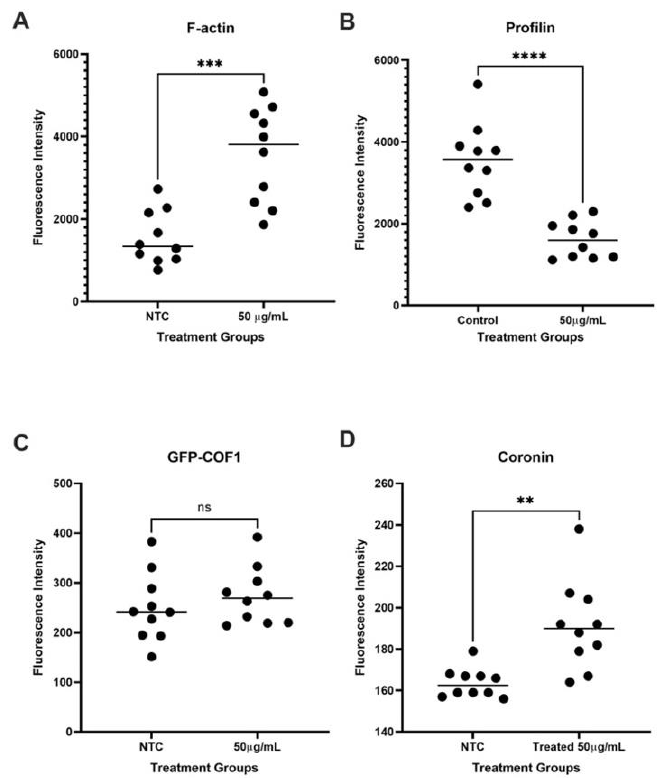
Figure 12. Graphs show the level of GFP-tagged actin-associated proteins. ( A ) F-actin stained with Actistain488 dye, ( B ) Pfy1-GFP, ( C ) GFP-Cof1, and ( D ) Crn1-GFP. ** p < 0.01, *** p < 0.001, **** p < 0.0001 .